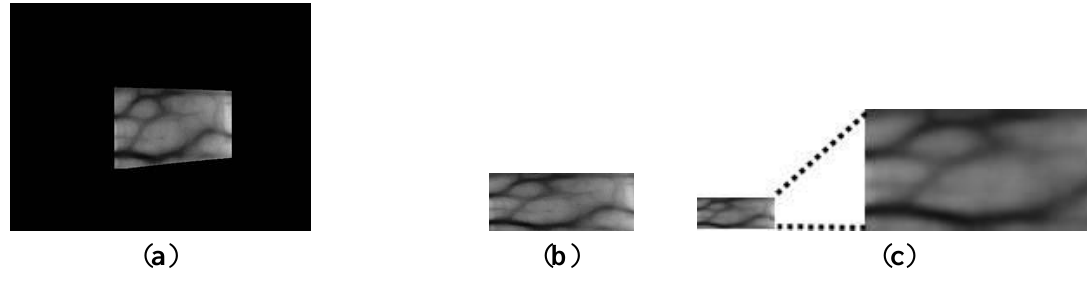
Figure 15. Images obtained using size normalization and downsampling: ( a ) original image with the detected finger boundaries; ( b ) a rectangular 150  60 pixel image using linear stretching based on the detected finger boundaries; and ( c ) a downsampled 50  20 pixel image.